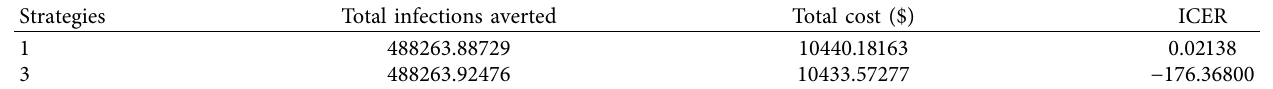
Table 4: Comparing cost and beneft of strategies 1 and 3.